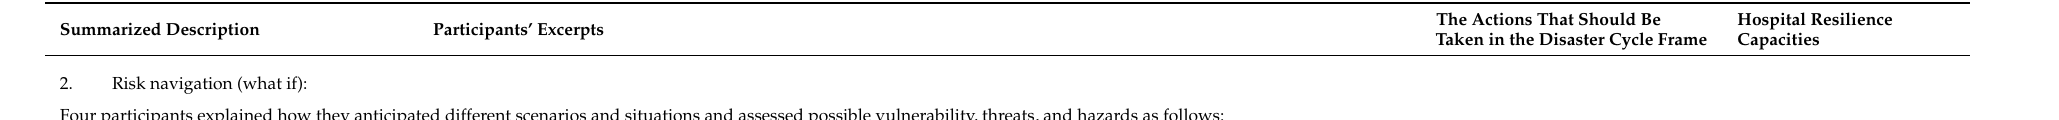
Table 3. Risk assessment and